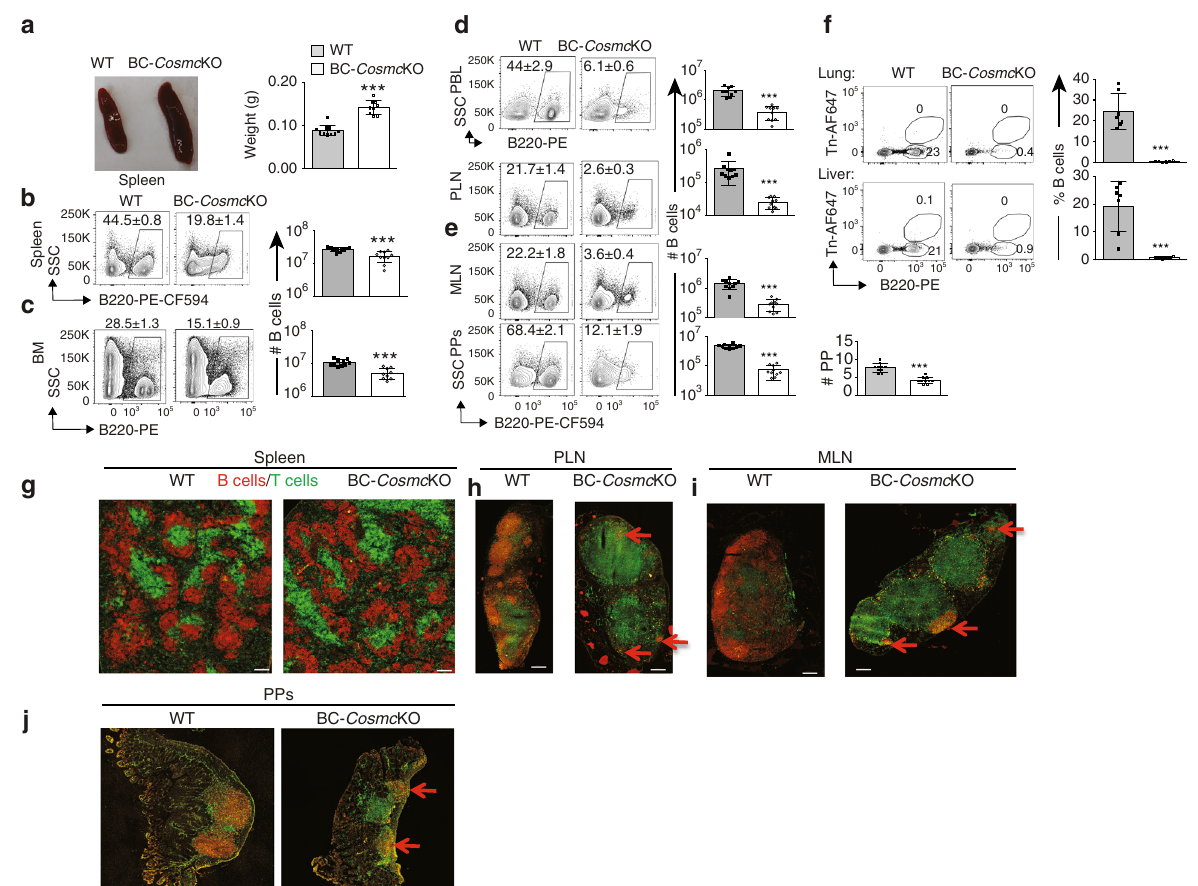
Fig. 1 Substantial reduction of B cells number in BC- Cosmc KO mice lymphoid organs. Both WT littermate control and BC- Cosmc KO mice at 8 weeks old were used in experiments. Each symbol (black square and open circle for WT and BC- Cosmc KO, respectively) represents an individual mouse. a representative photograph of spleens of WT littermate control ( n = 10) and BC- Cosmc KO ( n = 9) mice. Statistical analysis of spleen weight is shown in bar graph and p value < 0.0001. b – f Frequencies and numbers of B220 + B cells were determined in indicated tissues by fl ow cytometry ( n = 10 for WT, n = 10 for BC- Cosmc KO for all tissues, except for n = 9 for WT in PBL, and n = 9 for BC- Cosmc KO in BM): ( b ) spleen, p value < 0.0001, ( c ) bone marrow (BM), from two femurs, p value < 0.0001, ( d ) PBL per ml, and PLNs, both p values < 0.0001. e Mesenteric lymph node (MLN) and Peyer ’ s Patches (PPs), the numbers of PPs, and all of p values < 0.0001, and ( f ) Co-stained with antibody against abnormal O-glycan structure (Tn) in lung, p value < 0.0001 and liver, p value = 0.0004. Data are presented as average ±SD of each genotype. g – j Representative immuno fl uorescence staining of the cryostatic sections ( n = 5) of spleen ( g ), PLN ( h ), MLN ( i ), and PPs ( j ), stained with anti-CD19-PE for B cells and anti-Thy1.2-FITC for T cells, and acquired at ×10 magni fi cation. Scale bar represents 200 µ m. Red arrow points to the location of the B cells. Unpaired two-tailed Student ’ s t tests were performed